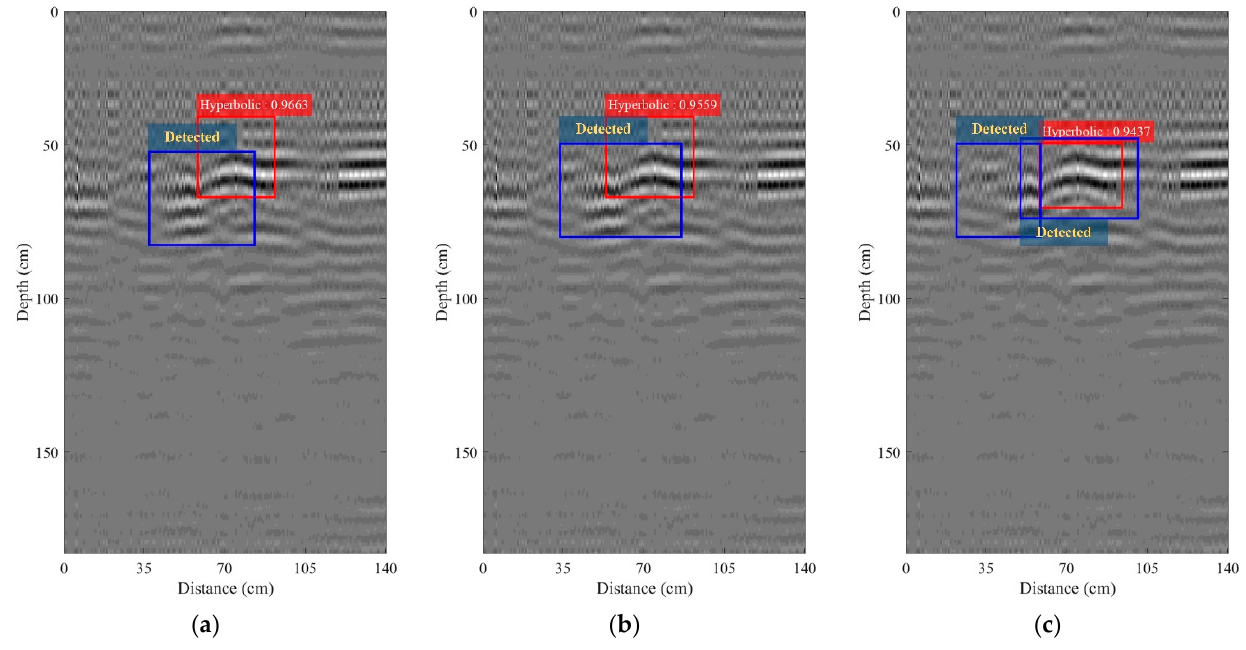
Figure 17. B-scan image collected using the maintenance train-mounted GPR system on the railway and obtained from performing bandpass filtering: ( a ) Bf = 100 MHz; ( b ) Bf = 150 MHz; ( c ) Bf = 200 MHz.